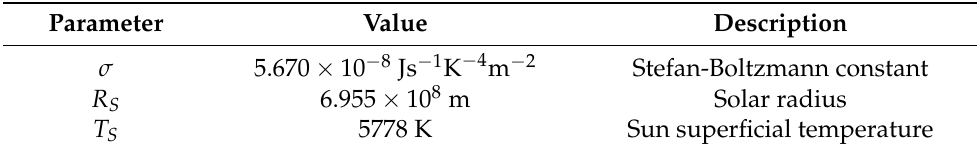
Table 2. Fundamental physical parameters for the solar